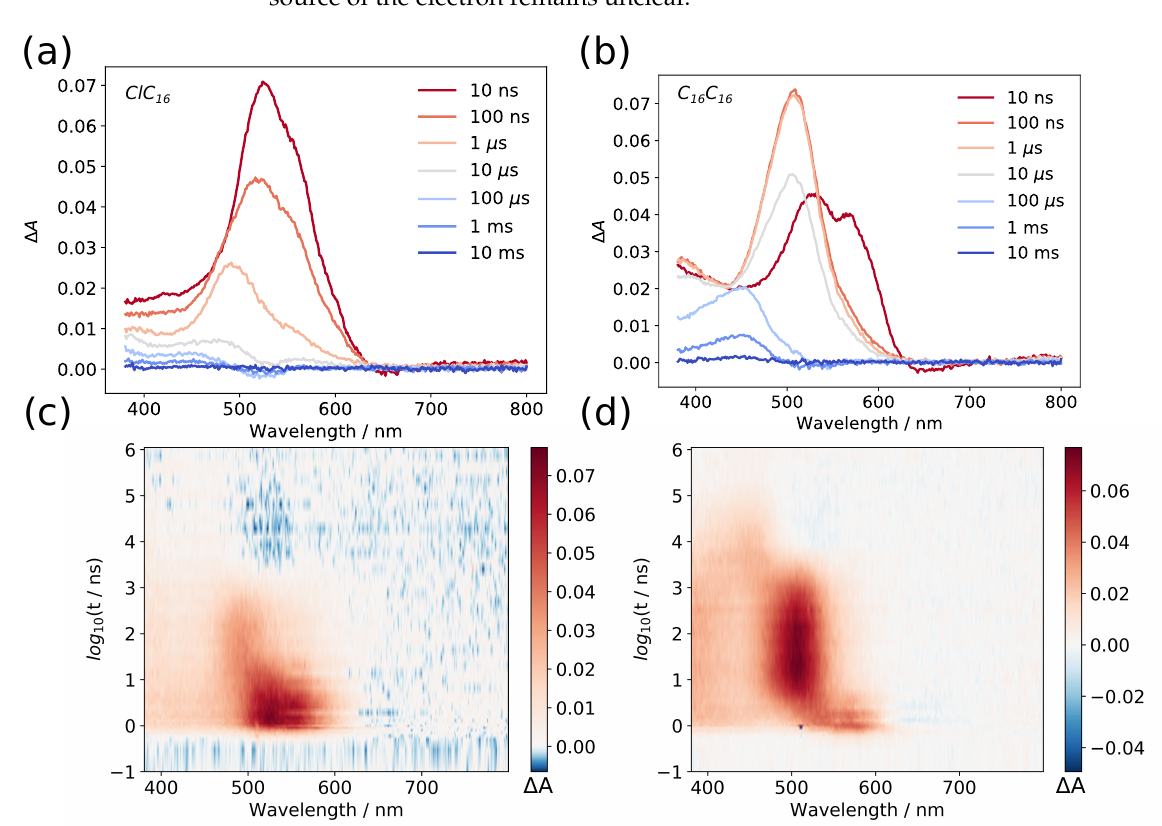
Figure 2. Nanosecond time-resolved spectra of ( a ) ClC 16 and ( b ) C 16 C 16 at a few selected delays, and their respective transient matrices ( c , d